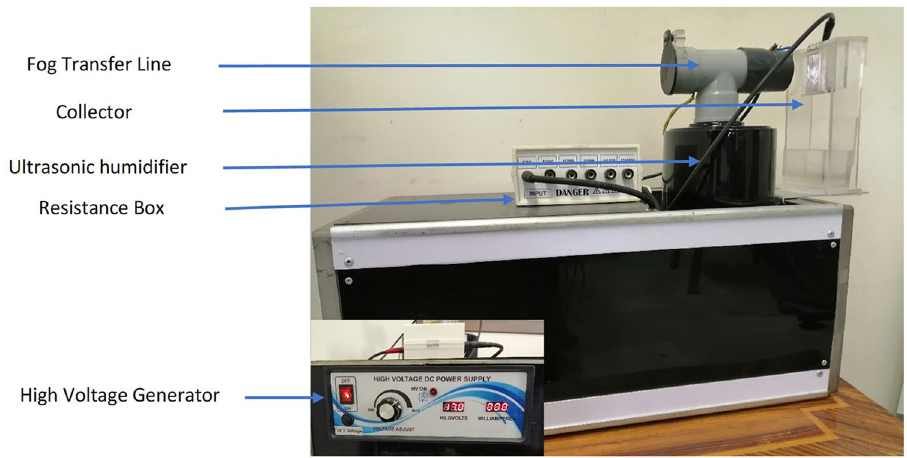
Fig. 1 The experimental setup for fog harvesting with the main parts of the system